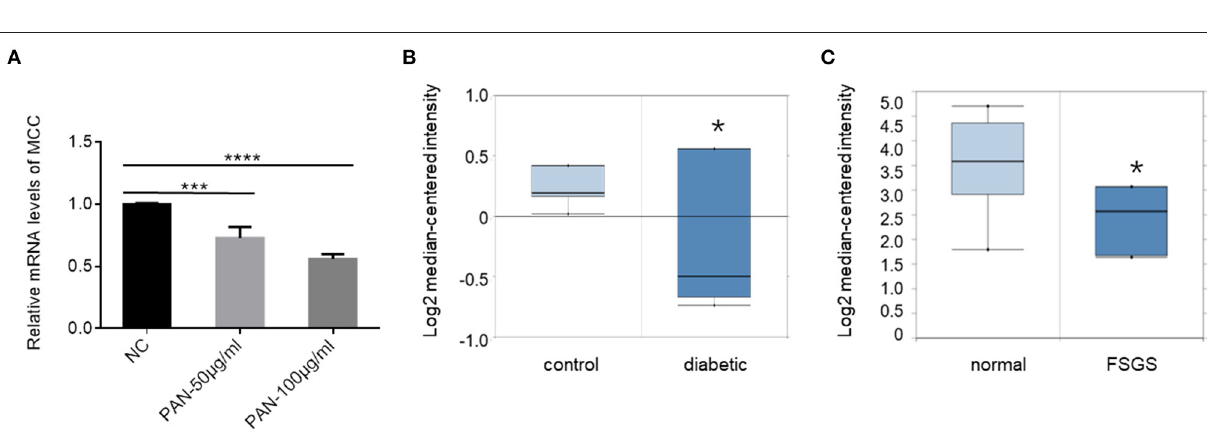
FIGURE 10 | MCC downregulation in podocyte injury and podocytopathy. (A) qPCR analysis of cultured podocytes treated with or without PAN for 24h, showing a significant downregulation of MCC by PAN. The results represent the mean ± SD of three independent experiments; *** p < 0.001, **** p < 0.0001, statistically very significant; (B) Nephroseq database search showed MCC downregulation in glomeruli of diabetic mice (eNOS-deficient C57BLKS db/db) ( n = 7) compared with the non-diabetic control mice ( n = 5). * p < 0.01; (C) Nephroseq database search revealed downregulation of MCC in glomeruli of FSGS patients. Normal control, n = 9; FSGS patients, n = 6; * p < 0.05, statistically